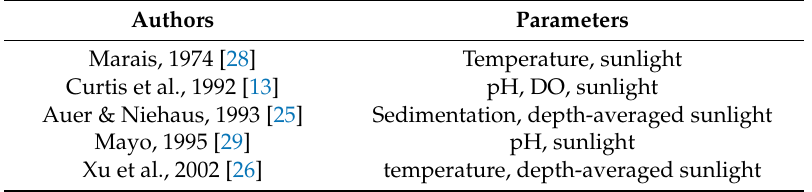
Table 1. Disinfection models predicting total coliform concentrations and their